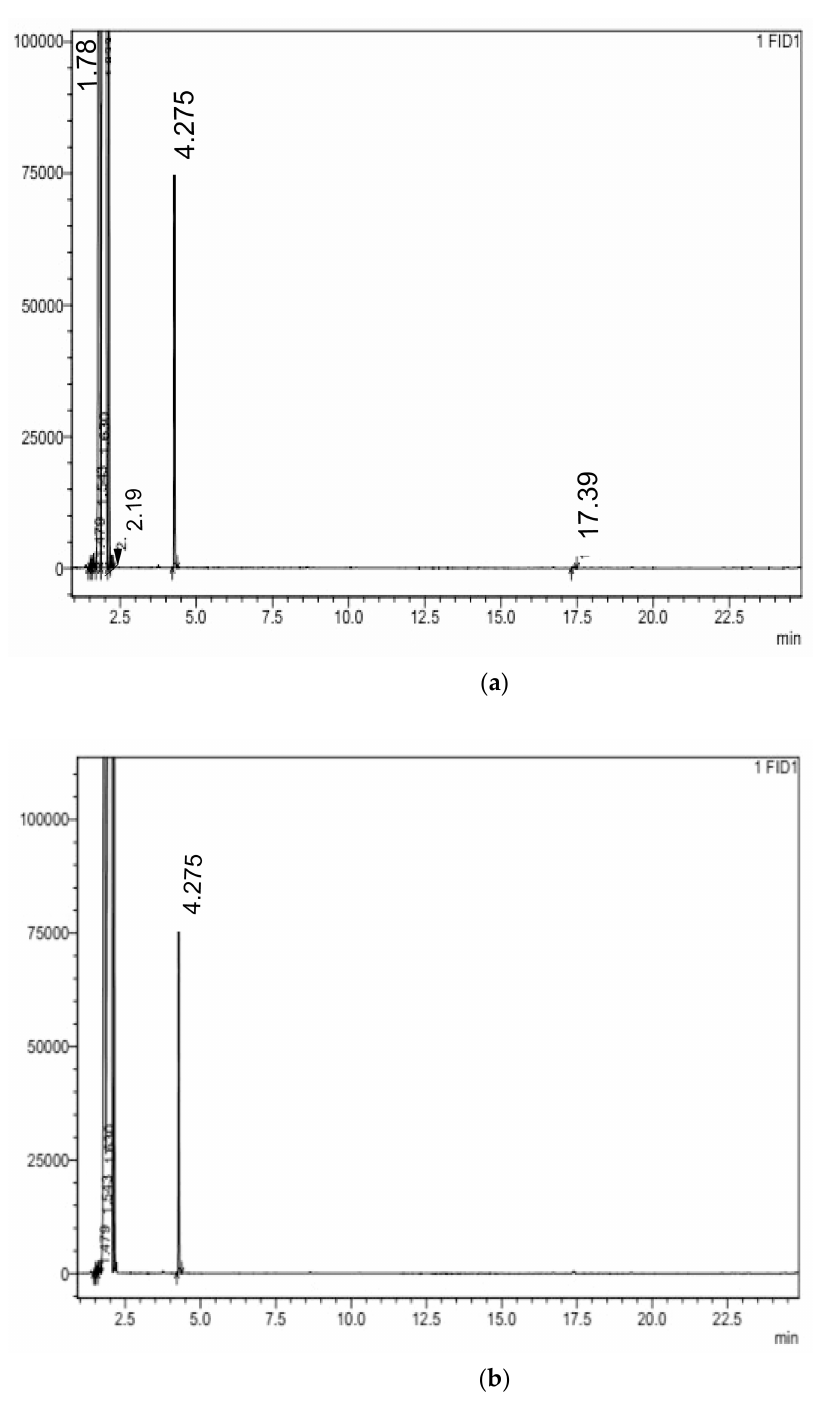
Figure 8. ( a ) GC of the enzymatically produced EV and ( b ) EV after purification. The purified EV was further characterized by 1 H-NMR spectroscopy to identify and confirm the product. In this assessment, the 1 H-NMR spectrum of EV revealed six types of 14 hydrogen atoms, which were unique for EV (CAS: 539-82-2) (Figure 9). The signals with chemical shifts δ (ppm) at 0.84 (3H, triplet, —CH 3 ) and 1.17 (3H, triplet, —CH 3 ); 1.26 (2H, sextet, —CH 2 ), 1.51 (2H, quintet, —CH 2 ), and 2.19 (2H, triplet, —CH 2 ); and 4.05 (2H, quartet, —OCH 2 ) corresponded to methyl, methylene, and oxymethylene hydrogen at- oms. Protons ‘A’ ( δ = 0.84 ppm) and ‘B’ ( δ = 1.17 ppm) appeared at lower magnetic fields. In comparison, proton ‘F’ of oxymethylene showed a chemical shift of δ = 4.05 ppm due